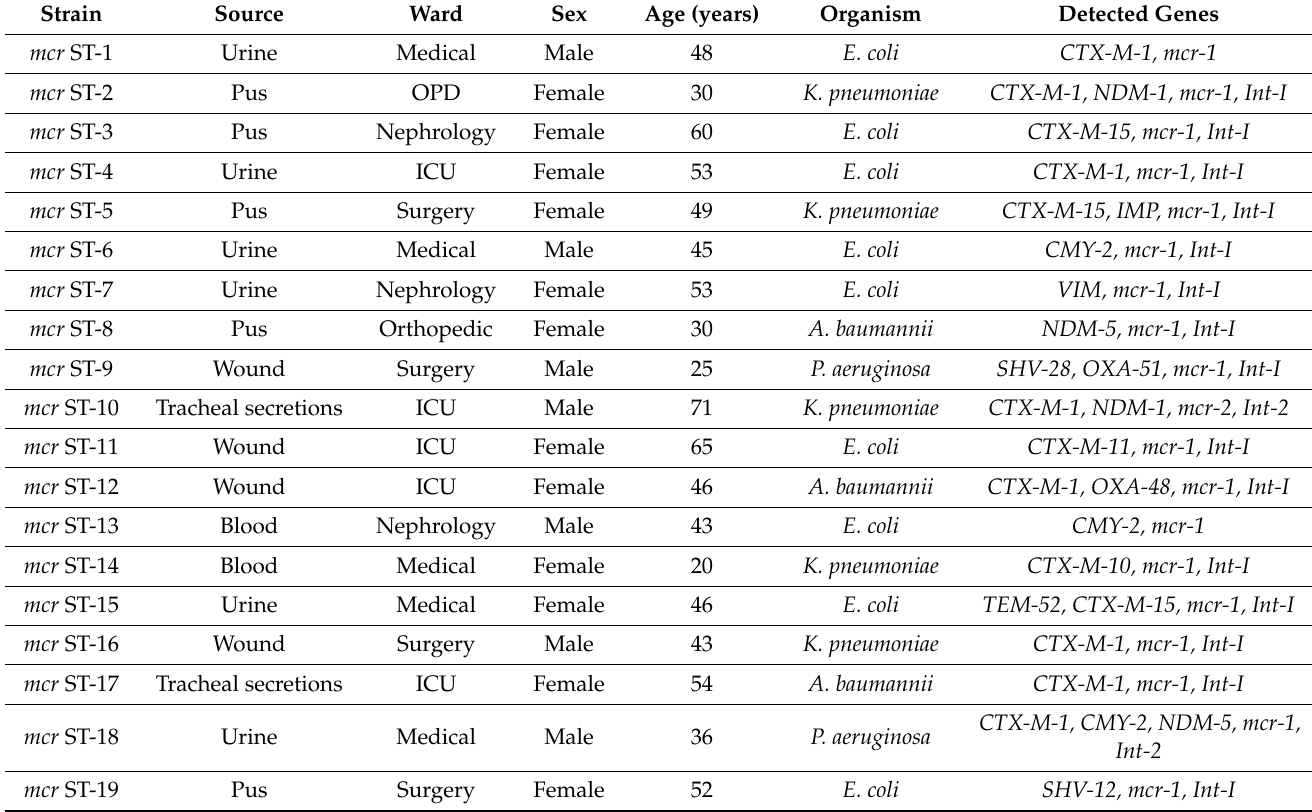
Table 3. Demographic and clinical characteristics and the co-existence of antibiotic-resistant genes in each gram-negative mcr -positive